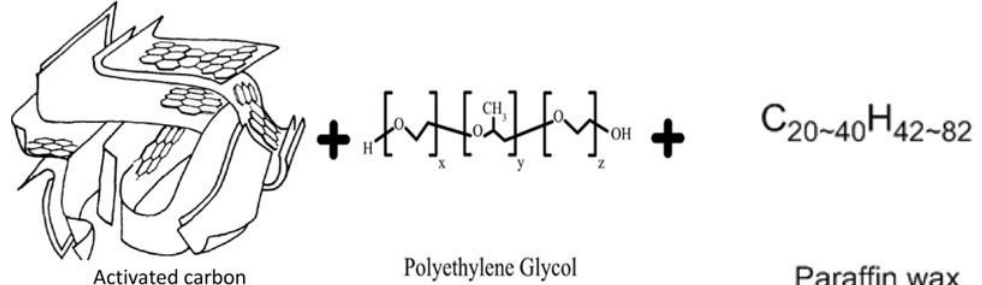
Figure 1. Molecular structure of ACMPs, PEG, and organic PCM [29]